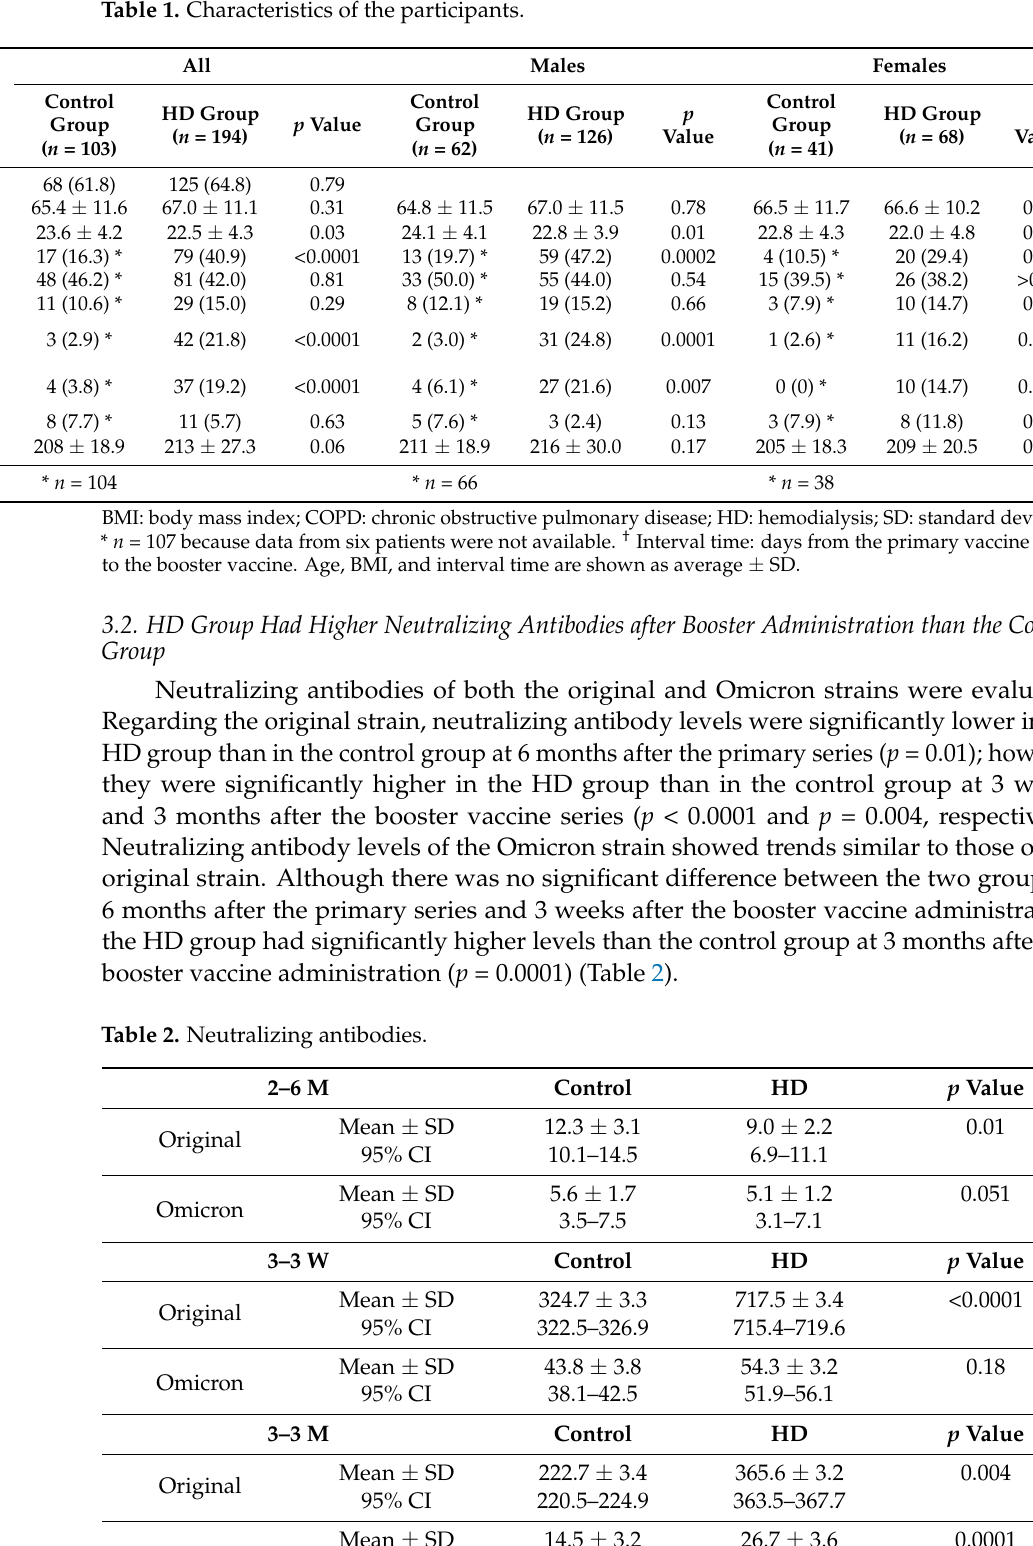
Table 1. Characteristics of the participants.